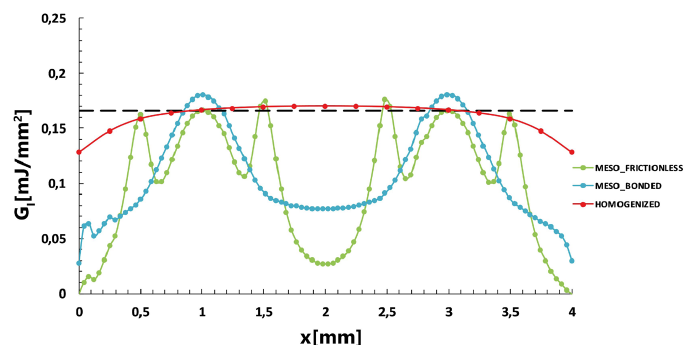
Figure 9. Values of the energy release rate on the delamination front for point 1 of Figure 8. The dashed black line represents the critical value 166 mJ/mm 2